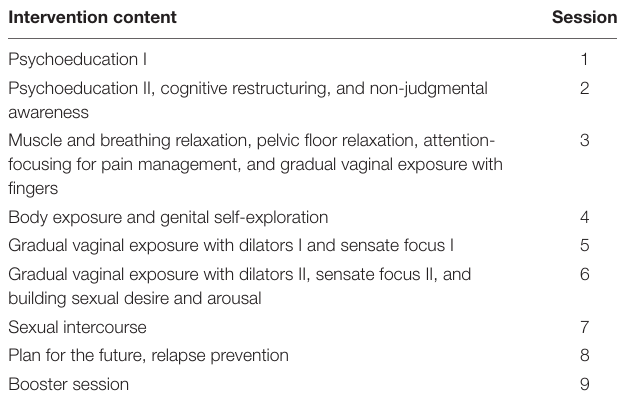
tABlE 1 | Content of the GPPPD